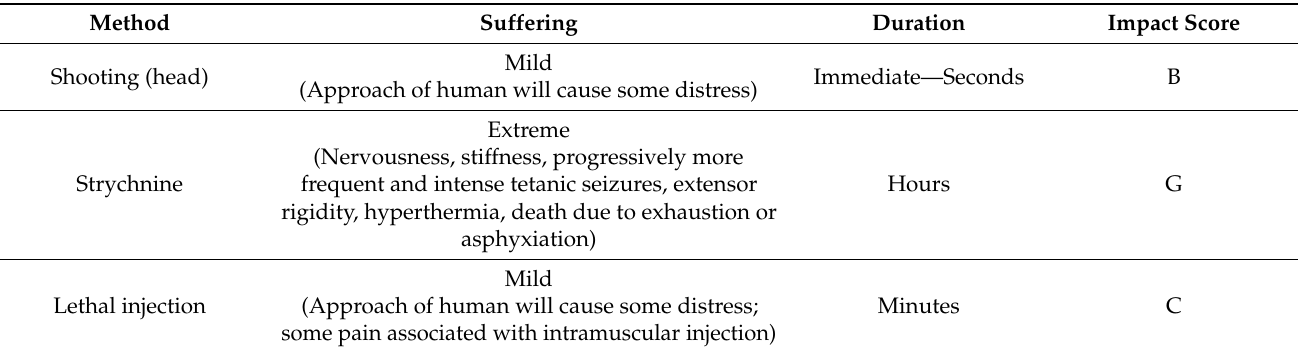
Table 3. Part B assessments of three methods of killing restrained wild dogs ( Canis familiaris )